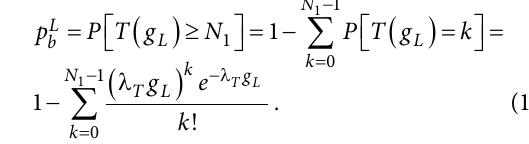
Fig. 3. Blockage and overflow of short left-turn lane under left- through phasing: a – signal phase sequence; b – blockage of short left-turn lane during the red phase for both left-turn and through movements; c – overflow of short left-turn lane during the red phase for both left-turn and through movements